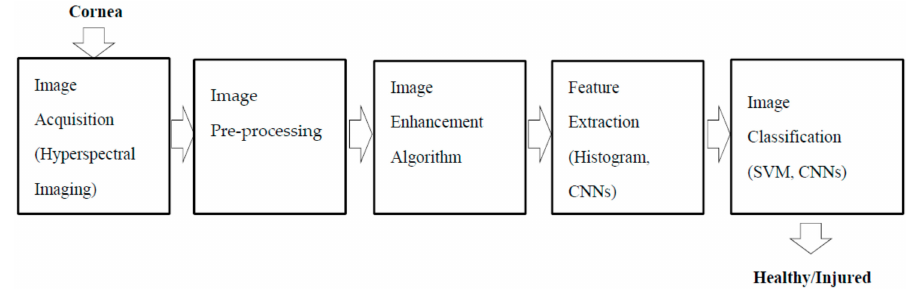
Figure 1. Corneal epithelium appraisal using hyperspectral imaging and image processing analysis.